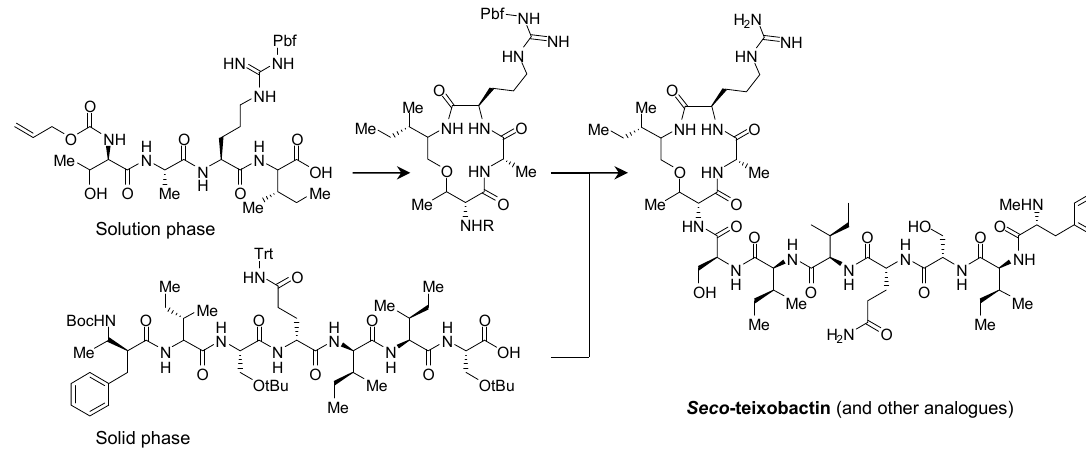
Figure 1. Outline of the synthesis of teixobactin analogues.